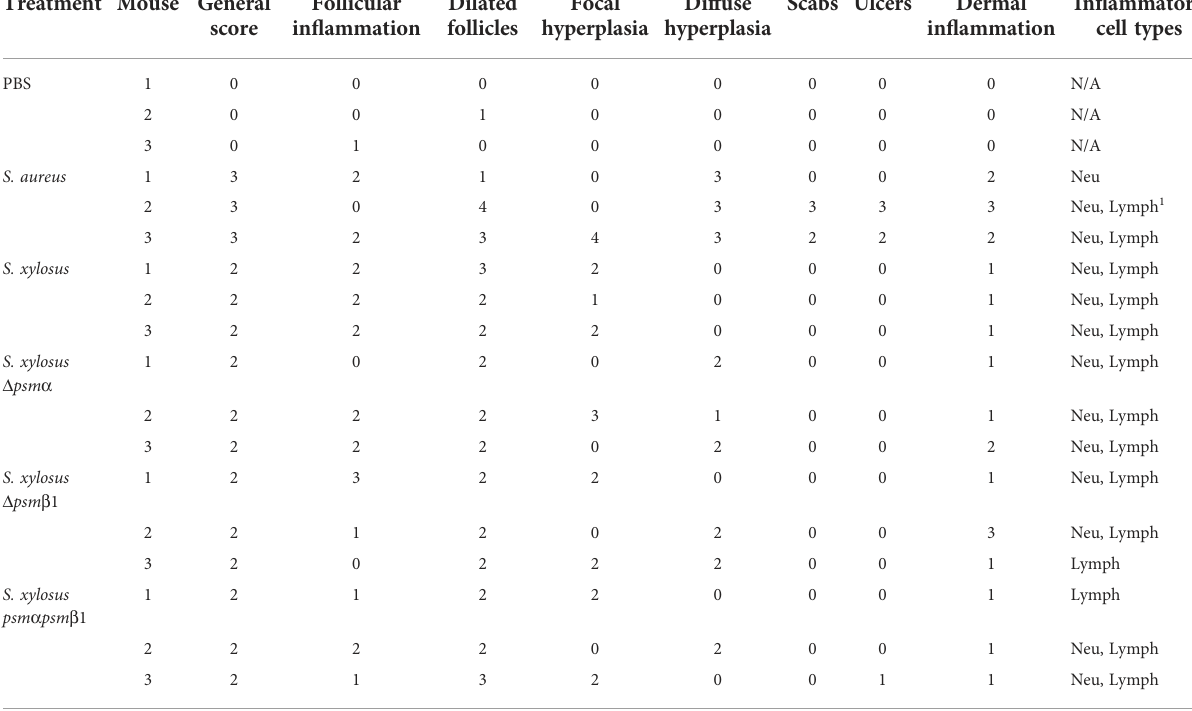
TABLE 2 Histological evaluation of skin from colonized mice in the atopic dermatitis animal model. Treatment Mouse General